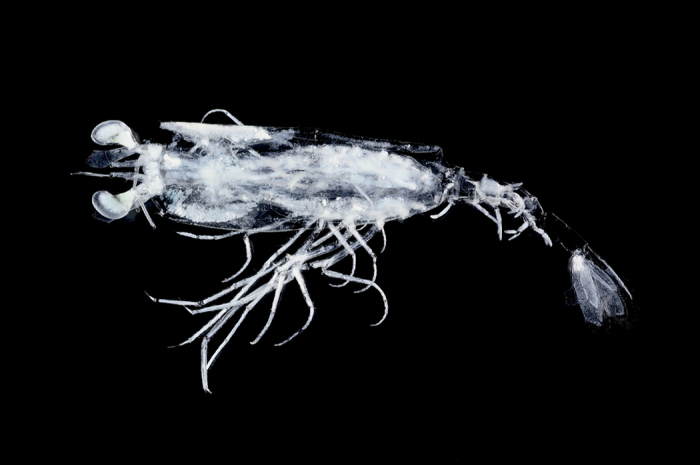
Amphionides reynaudii (H. Milne Edwards, 1833).Specimen sequenced herein, collected north of Gran Canaria, stage 8 larva (NTOU M10872).